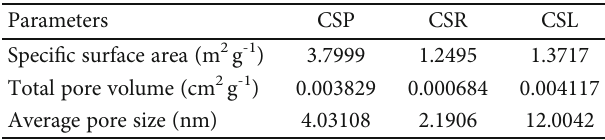
Table 2: The porosity characteristics of corn stover pith, rind, and